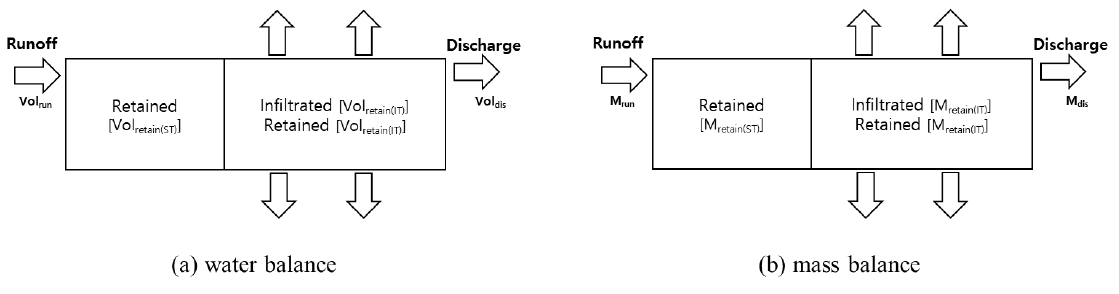
Figure 2. ( a ) Water balance and ( b ) mass balance analysis in the infiltration trench